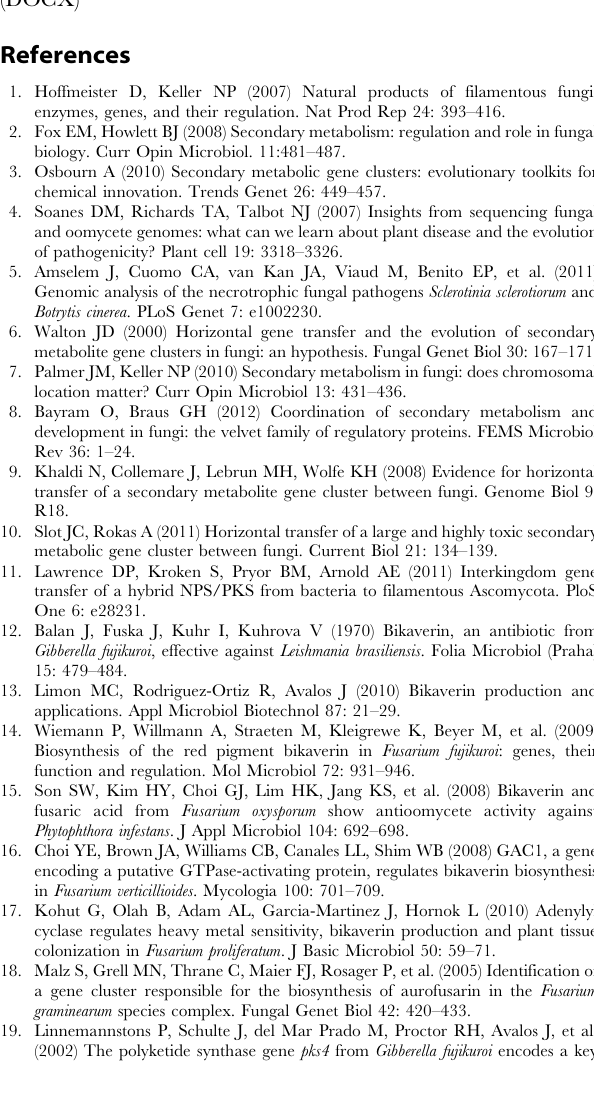
Table S3 Phenotypes and genotypes of 1750 6 SAS405